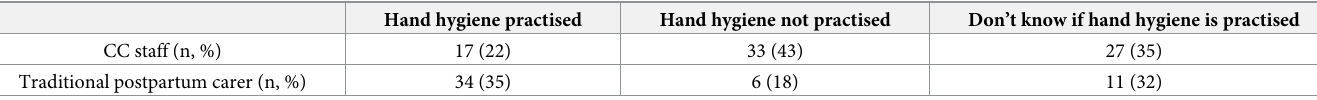
Table 2. Mothers’ perception that hand hygiene was practised before handling